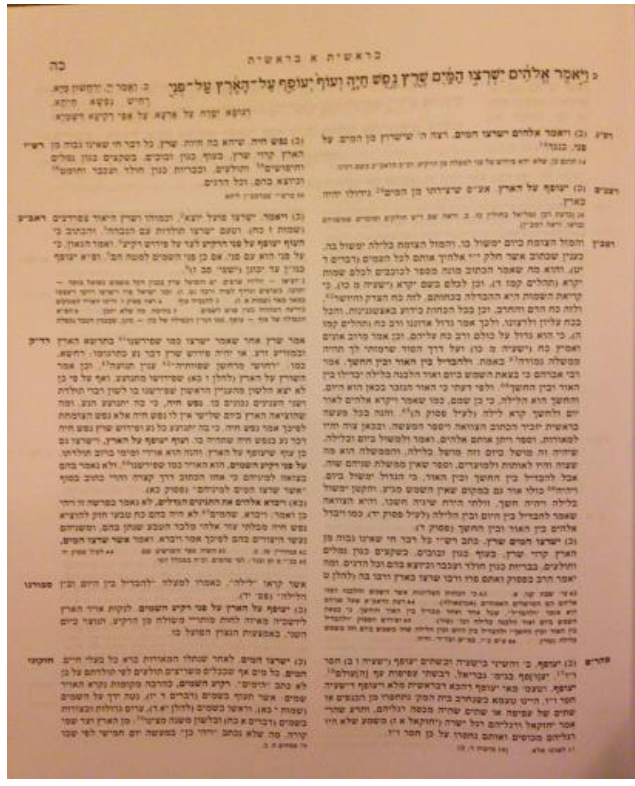
Figure 1. Page of Torat Chaim.